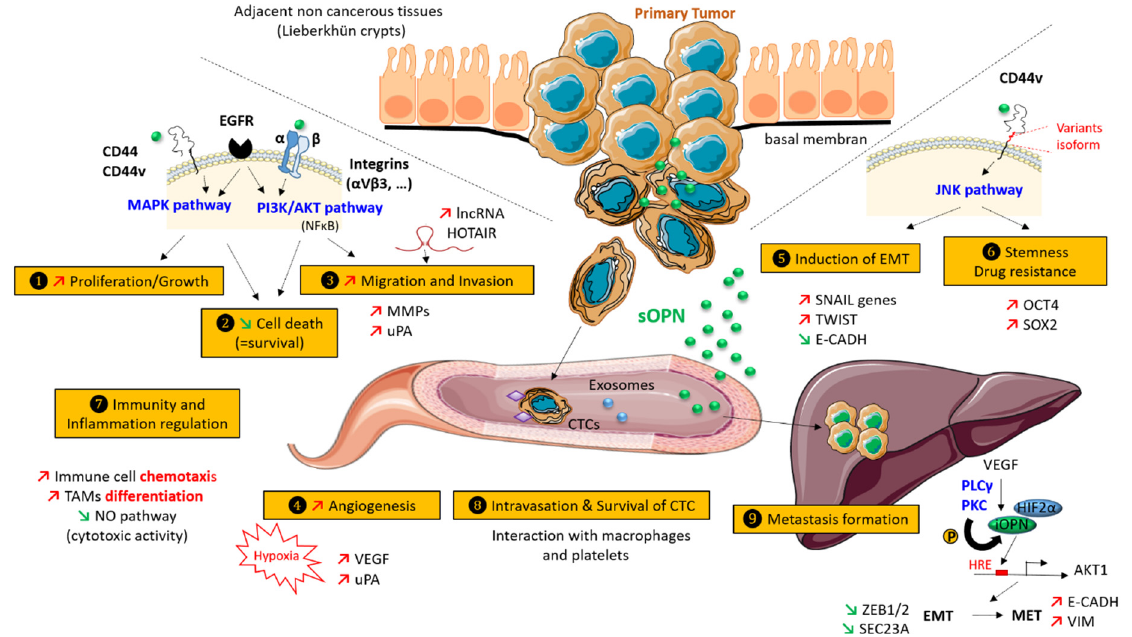
Figure 2. Role of OPN in CRC progression. OPN is involved in cancer progression by regulating various aspects of tumor progression and metastasis, including (1) increased proliferation and cell growth, (2) decreased cell death, (3) increased migration and invasion, (4) neo-angiogenesis, (5) promotion of the epithelial-mesenchymal transition (EMT), (6) increased stemness and drug resistance, (7) modulation of immunity and inflammation both at the primary and metastatic sites, (8) intravasation and survival of circulating tumor cells (CTC), and (9) promotion of liver metastasis. sOPN—secreted OPN; iOPN—intranuclear OPN; MET—mesenchymal to epithelial transition; HRE—HIF response element.